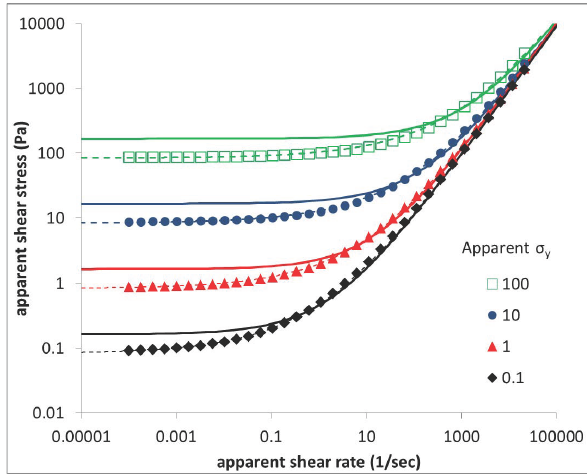
Figure 3: Simulated data points with yield stress values (see Ta- ble 4), their best fit (dashed lines) and the “true” flow curves calcu- lated from them (solid curves).